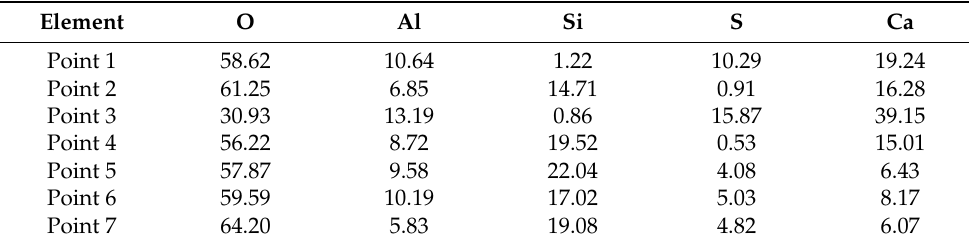
Table 2. EDS dotting analysis of clay samples (Atomic percentage